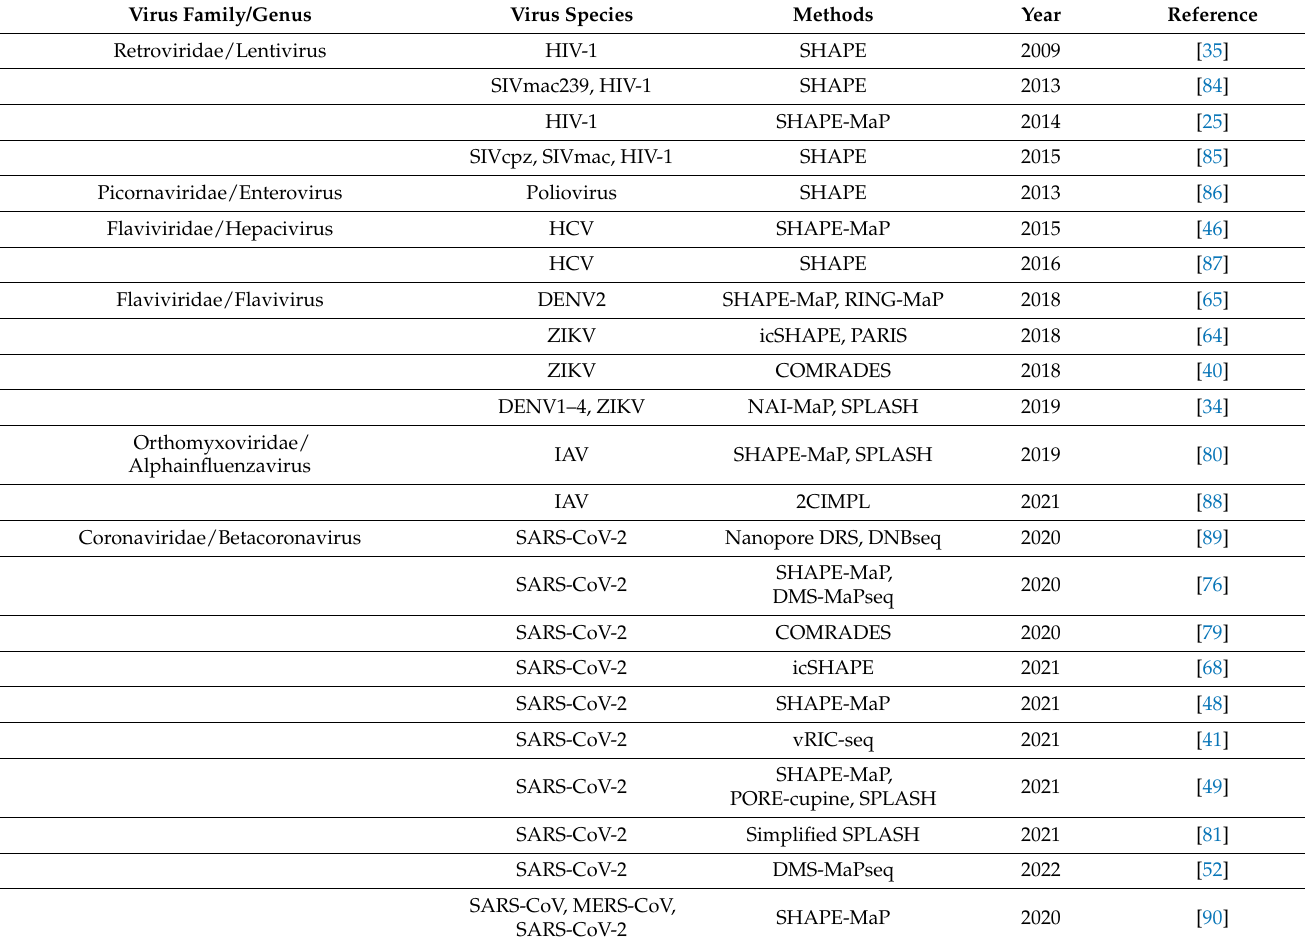
Table 3. Genome-wide RNA structure studies in